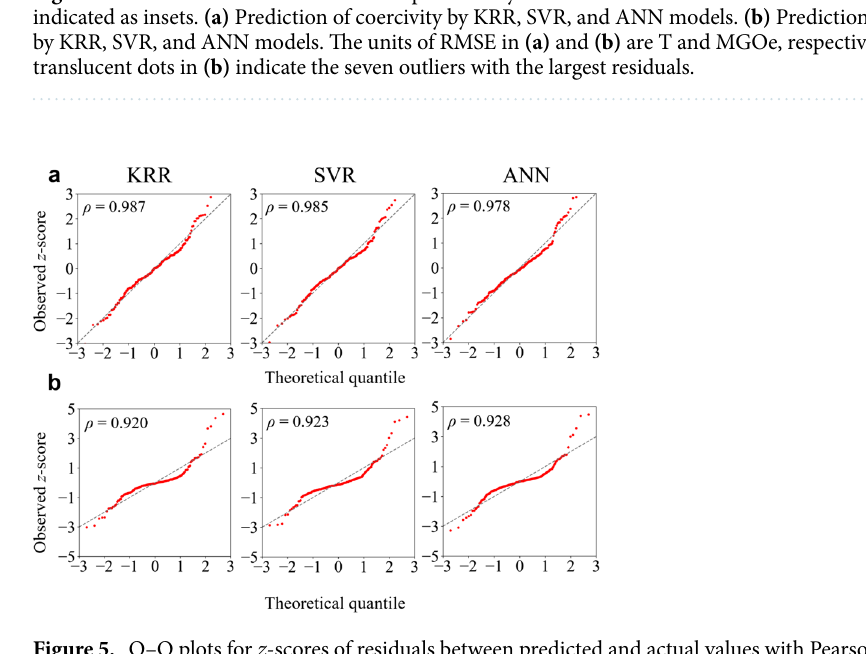
Figure 5. Q–Q plots for z -scores of residuals between predicted and actual values with Pearson correlation coefficient of each plot indicated in insets. (a) Q–Q plots obtained from prediction of coercivity by KRR, SVR, and ANN models. (b) Q–Q plots obtained from prediction of BH max by KRR, SVR, and ANN models. The gray lines in each graph are the trend lines to which the ideal Q–Q plot in each case should